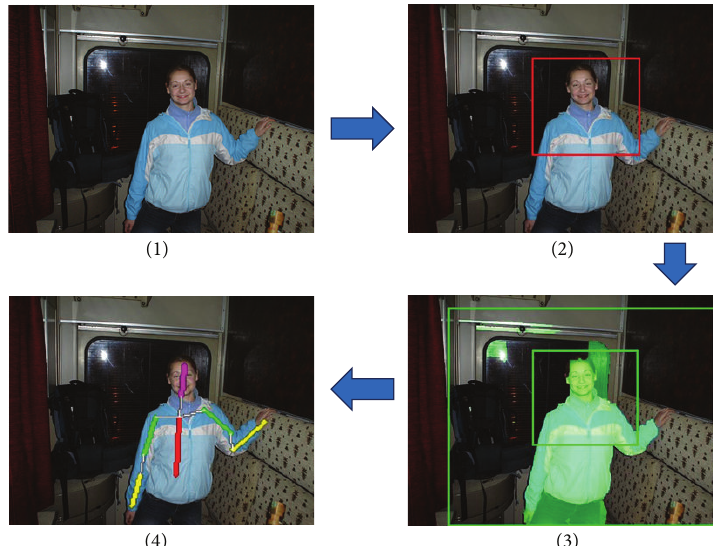
Figure 4: Main steps of upper-body detection and body parts localization. (1) Input image, (2) upper-body detection, (3) segmentation of the whole upper body from background, and (4) body part